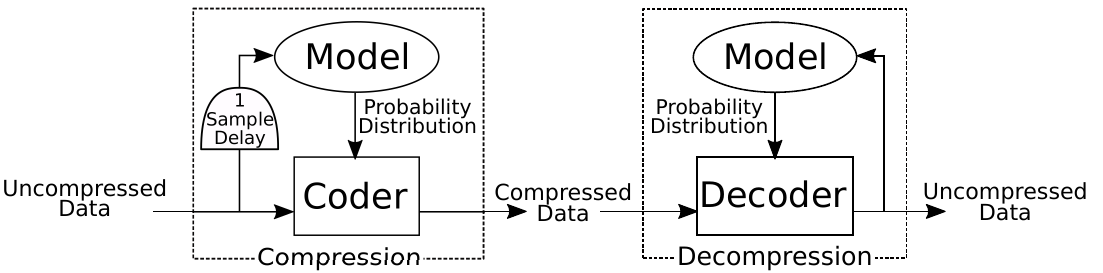
Figure 1. Generalized compression and decompression. Modeling and coding are independent. The model is mathematically identical for compression and decompression. The coder and decoder perform inverse operations parameterized by the probability